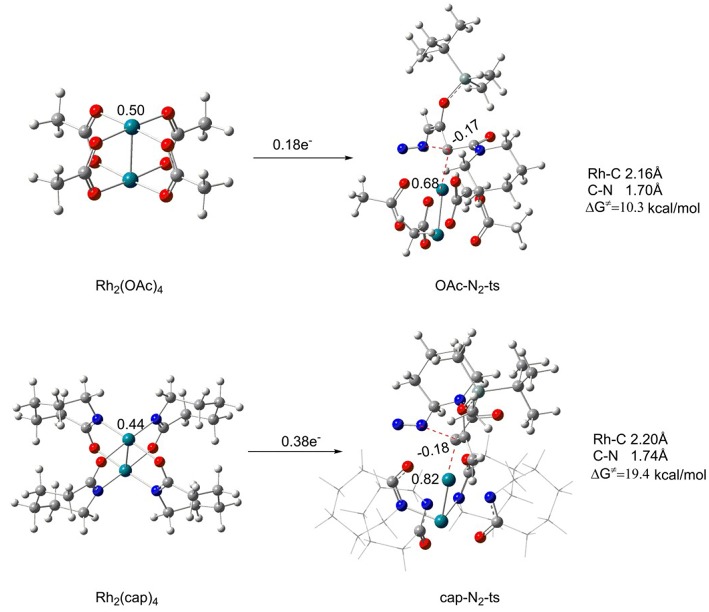
The initial carbenoid formation step of Rh2(OAc)4 and Rh2(cap)4.